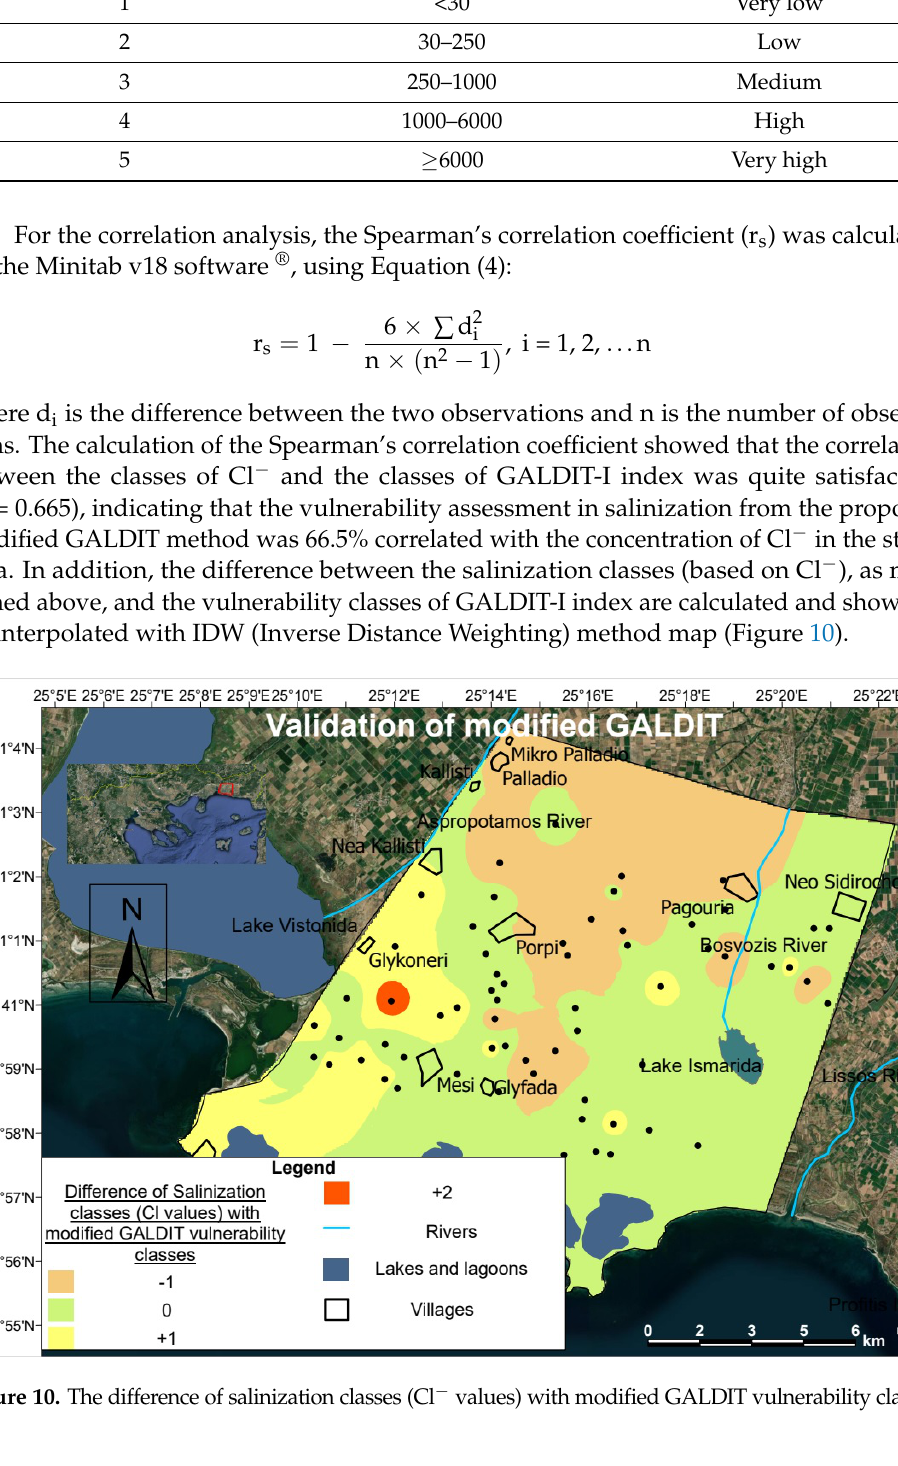
Table 6. Salinization classes for the correlation analysis.